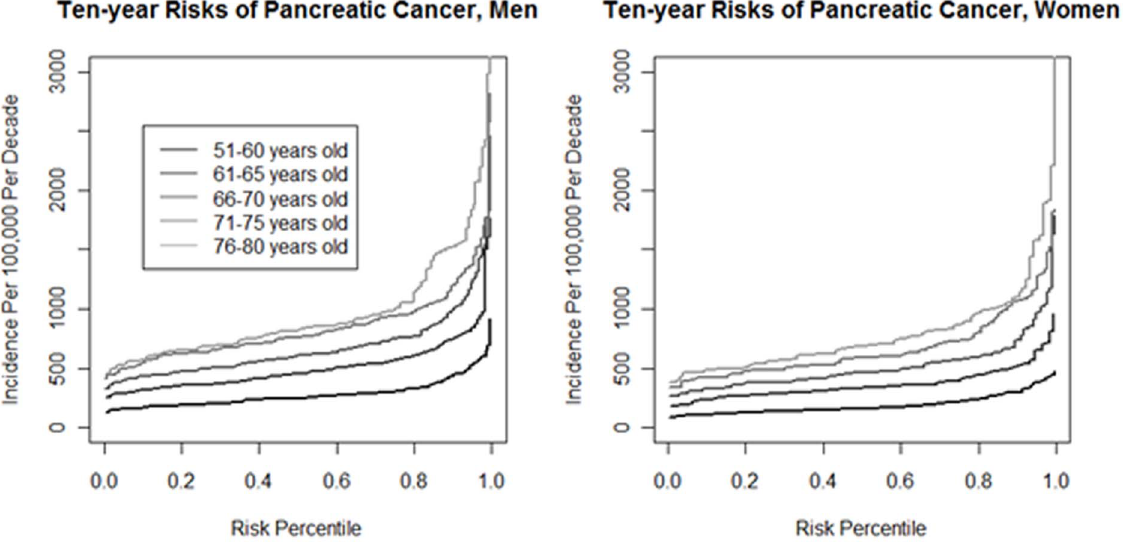
Figure 1. Ten-year risks of pancreatic cancer (y-axis), by age, gender, and risk score percentile (x-axis). The risk score includes smoking history, heavy alcohol intake, BMI, history of diabetes, family history of pancreatic cancer, ABO genotype and three common genetic variants associated with pancreatic cancer.